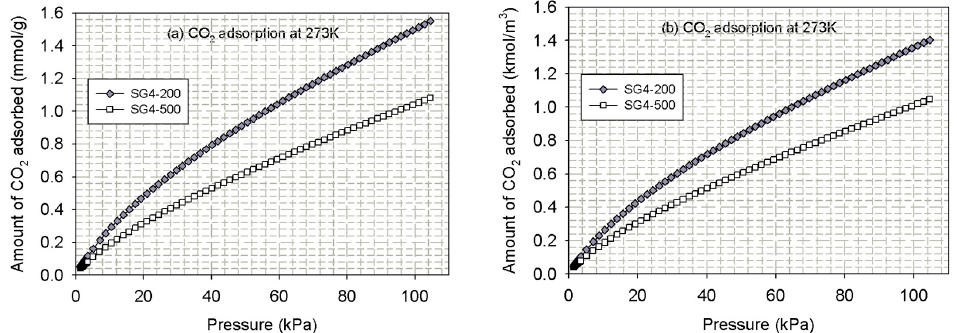
Figure 9. CO 2 isotherms at 273 K for porous silica glass prepared at pH 4, ( a ) adsorbed amount plotted in mmol/g and ( b ) adsorbed amount plotted in kmol/m 3 .